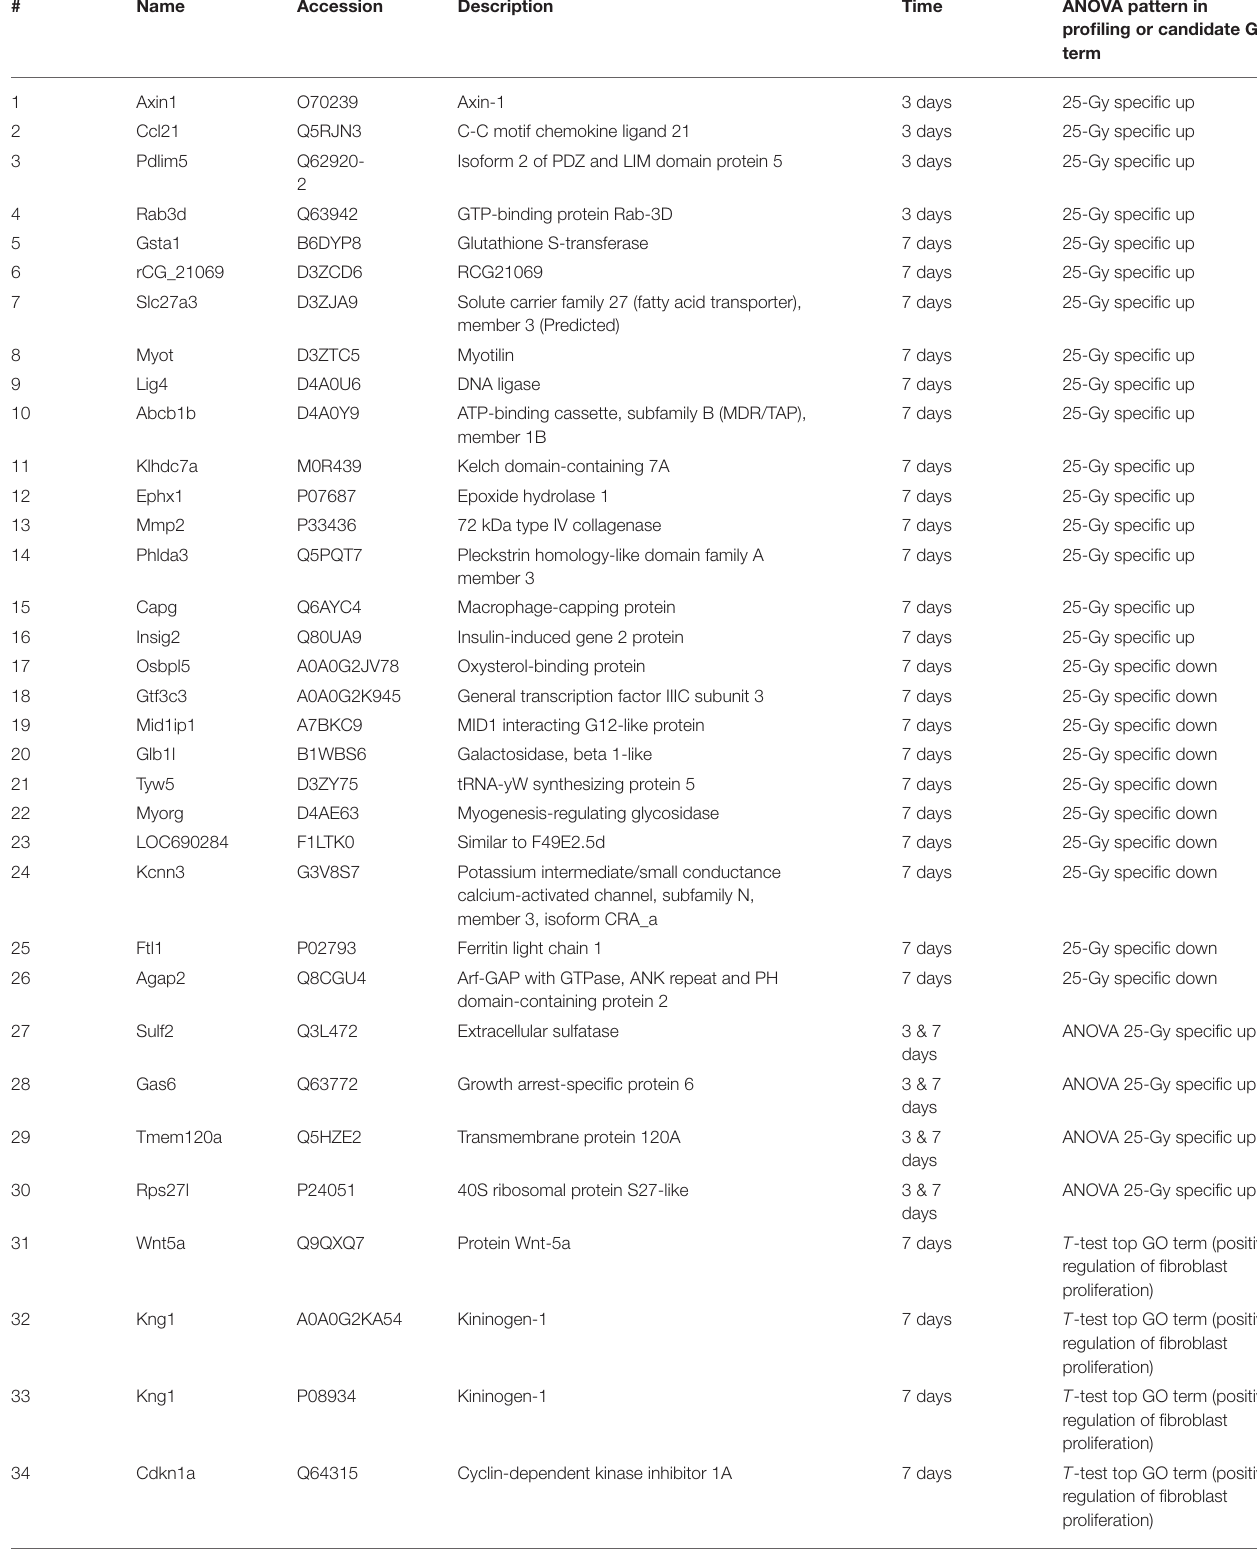
TABLE 1 | Complete list of validation target